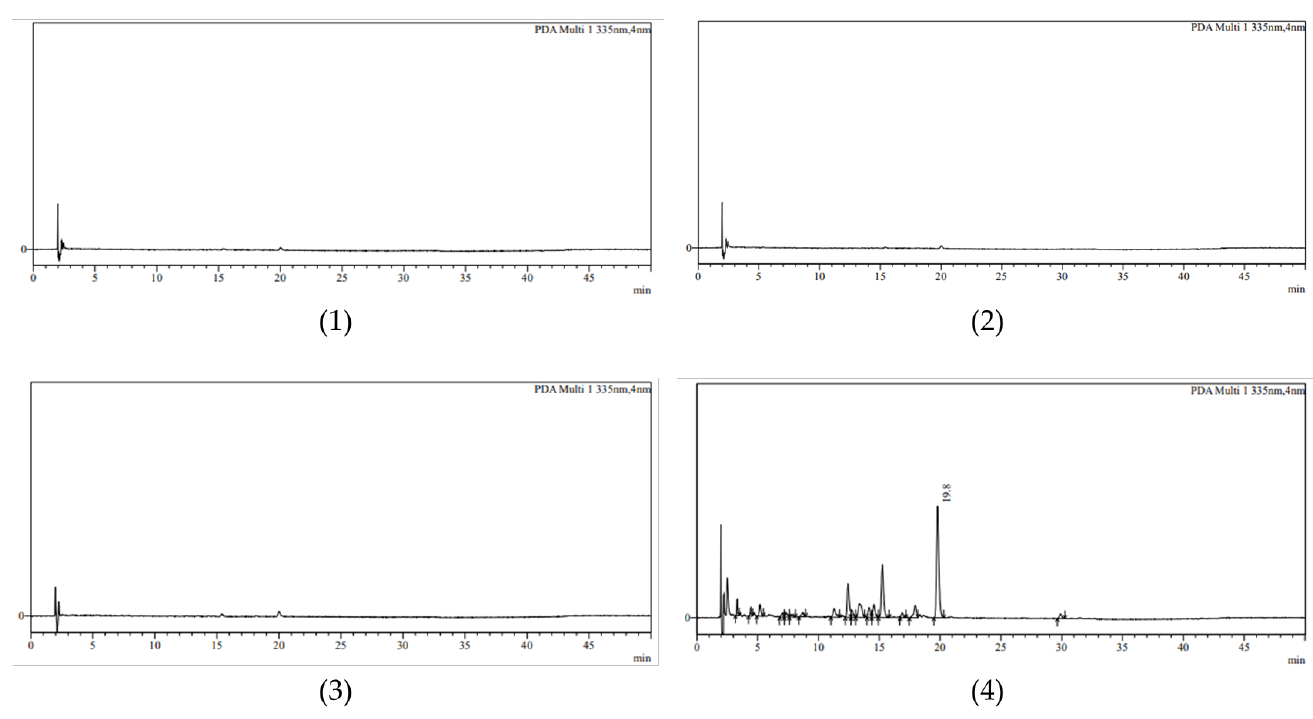
Figure 2. HPLC-DAD chromatogram according to the pretreatment method: ( 1 ) 0.1% AE cream dissolved in acetonitrile; ( 2 ) analysis after liquid–liquid extraction using acetone; ( 3 ) analysis after liquid–liquid extraction using hexane; ( 4 ) analysis after liquid–liquid extraction using dichloromethane.